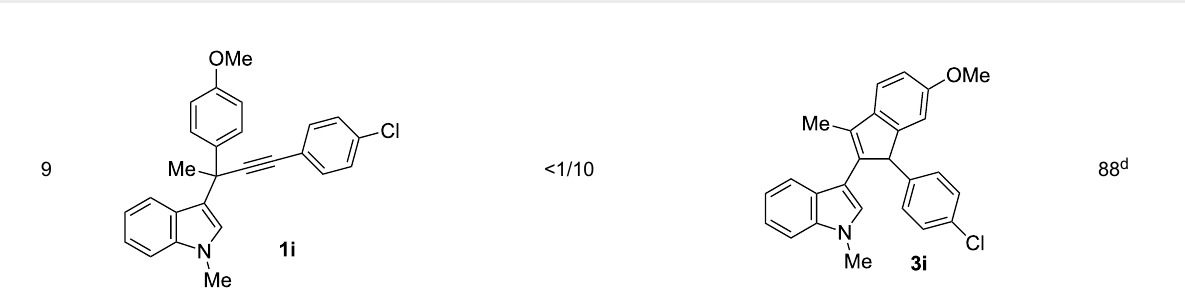
Table 2: Synthesis of 3-(inden-2-yl)indoles 4 by gold-catalyzed tandem 1,2-indole migration/Nazarov-type cyclization of 3-propargylindoles 1 . (continued)